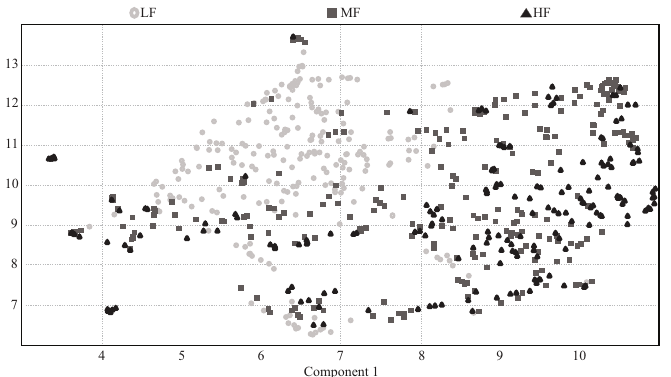
Figure 14. Distribution diagram obtained from applying the Uniform Manifold Approximation and Projection technique.